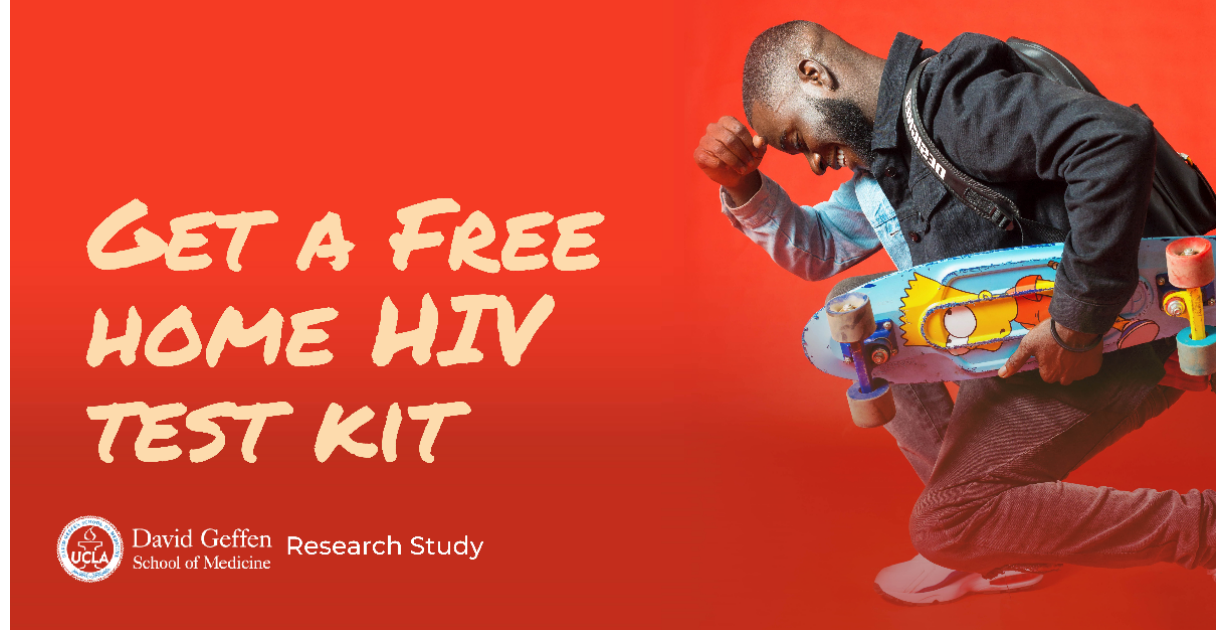
Figure 1. HIV self-test study advertisement developed by the study team for social media websites and dating